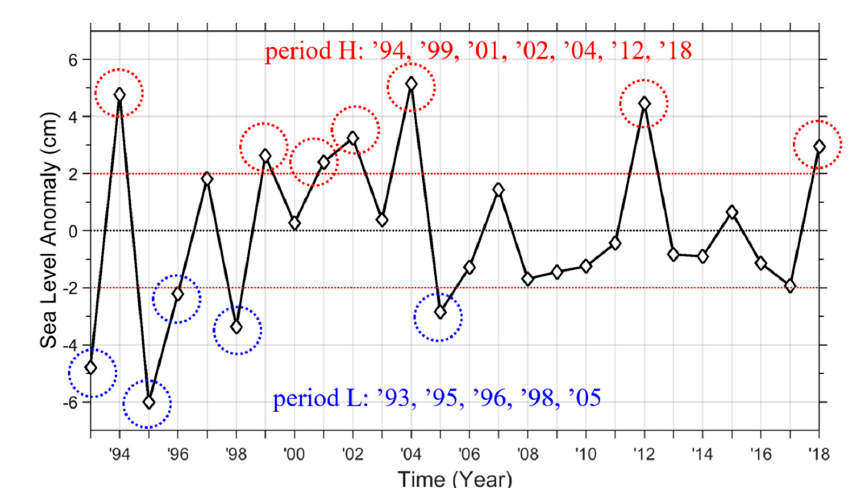
Figure 3. Time-series of the de-trended August sea-level anomalies averaged over the NEAMS from 1993 to 2018 are classified as seven high (higher than +2 cm) and five low (lower than − 2 cm) years. Period H (1994, 1999, 2001, 2002, 2004, 2012, and 2018) and period L (1993, 1995, 1996, 1998, and 2005) are represented by red and blue dotted circles, respectively. 0 cm here is the trend of August sea-level, the same as the red dashed line in Figure 2b.